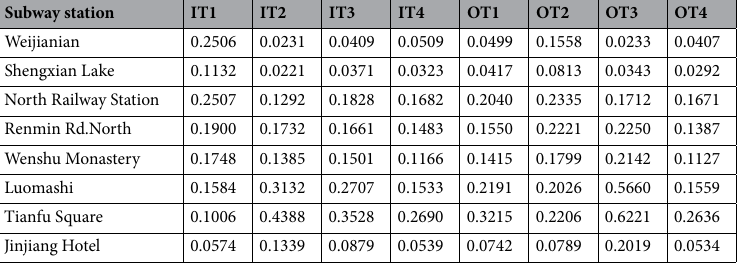
Table 7. Ridership during different time, normalized by Min–Max Normalization method.